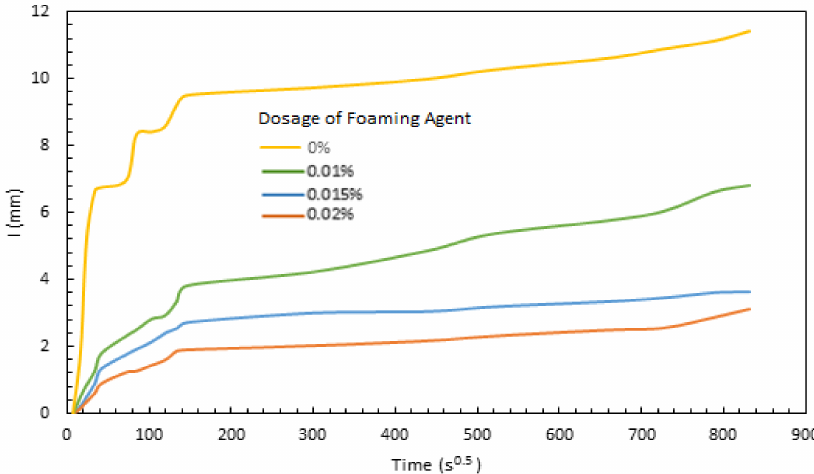
Figure 10. Sorptivity of non-aerated versus aerated slurries.